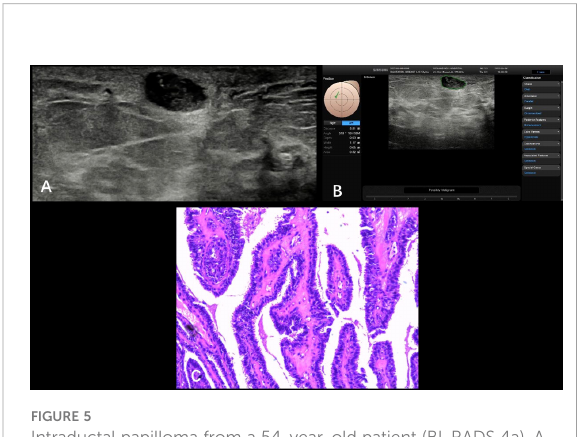
FIGURE 4 Non-speci fi c invasive carcinoma from a 49-year-old patient (BI- RADS 4b). A hypoechoic nodule (0.86 × 0.68 cm) was found at the 10 o ’ clock point of her right breast with smooth and irregular edges; the inner echoes detected with nonuniform distribution came with spotted hyper-echoes (A) . The S-Detect suggestion was “ possibly benign ” ; the BI-RADS classi fi cation was adjusted from 4b to 4a (B) . Pathological results are showed in (C) (HE, ×100). S-Detect gave a misdiagnosis due to the misrecognized microcalci fi cations that were found through operators.